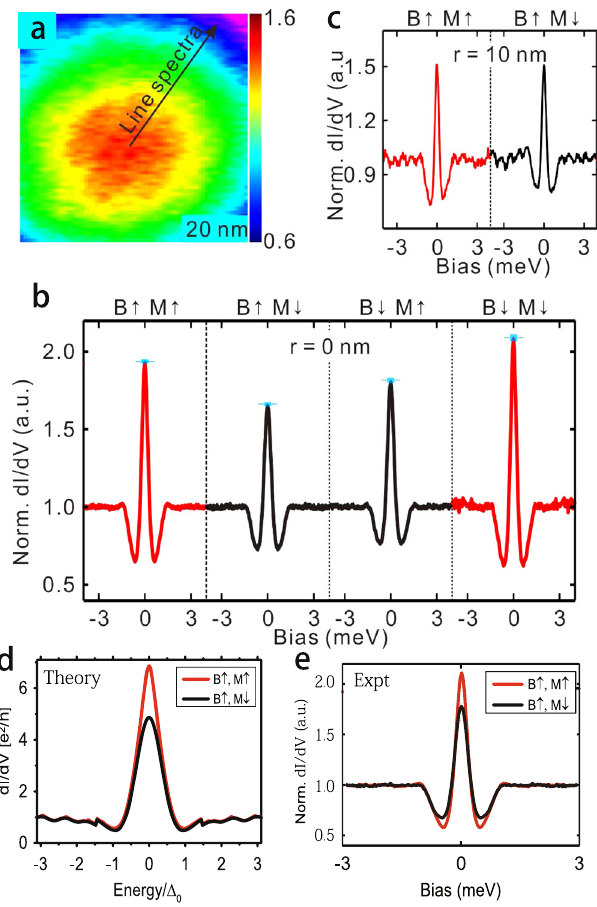
Fig. 8 a Zero bias dI/dV mapping of a vortex at 0.1 T with the spin non-polarized tip on the topological superconductor 5 QL Bi 2 Te 3 / NbSe 2 . b dI/dV at the vortex center measured with a fully spin polarized tip. Red curves are for parallel con fi guration and black curves are for antiparallel con fi guration. The blue lateral lines give the average values of the intensities in multi-measurements, the vertical bars are the standard error bars. c dI/dV at 10 nm away from the center of a vortex measured with a fully spin polarized tip, where the tunneling is found independent of the spin polarization. d and e Theoretical calculation of the dI/dV curves in two con fi gurations and the experimental results accordingly. a – e reprinted with permission from ref. 48, copyright 2016 by the American Physical